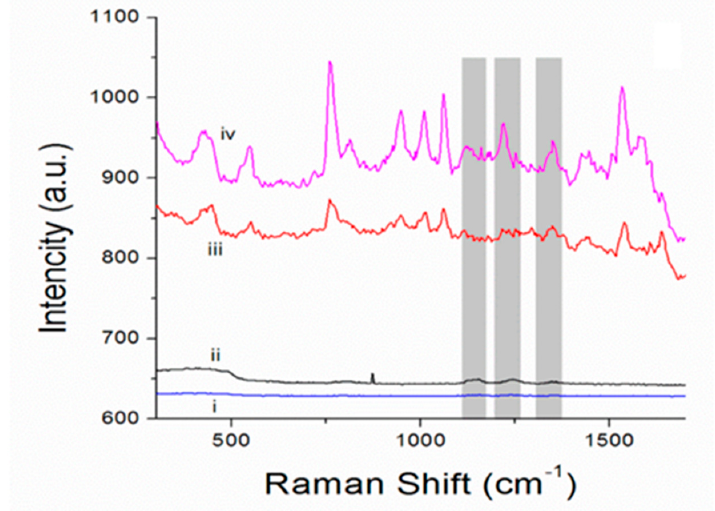
Figure 4. Raman spectra of dried BSA: ( i ) at 0.4 µ W and ( ii ) at 40 mW laser power, respectively. ( iii ) Raman spectrum of a water dispersion of porous Au microshells; ( iv ) SERS spectrum of BSA (2 mg/mL) in the presence of porous Au microshell dispersion, laser power 0.4 µ W. The characteristic scattering lines of BSA are marked with grey